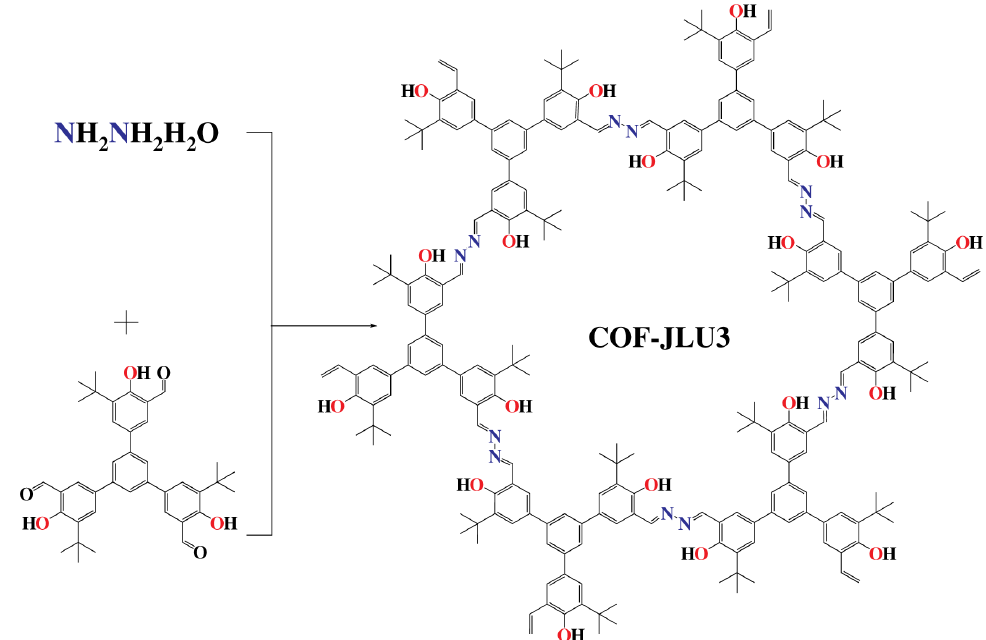
Figure 13: Synthesis and structure of COF-JLU3.